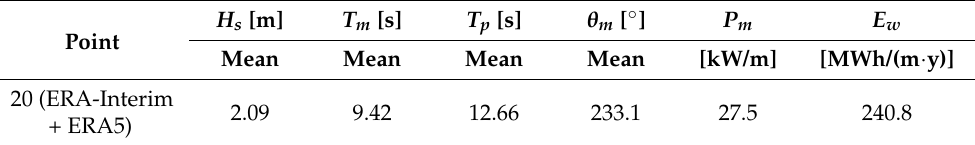
Table 2. Main wave climate parameters for the extended dataset (from January 2007 to December 2020) for point P20, obtained from ERA-Interim and ERA5